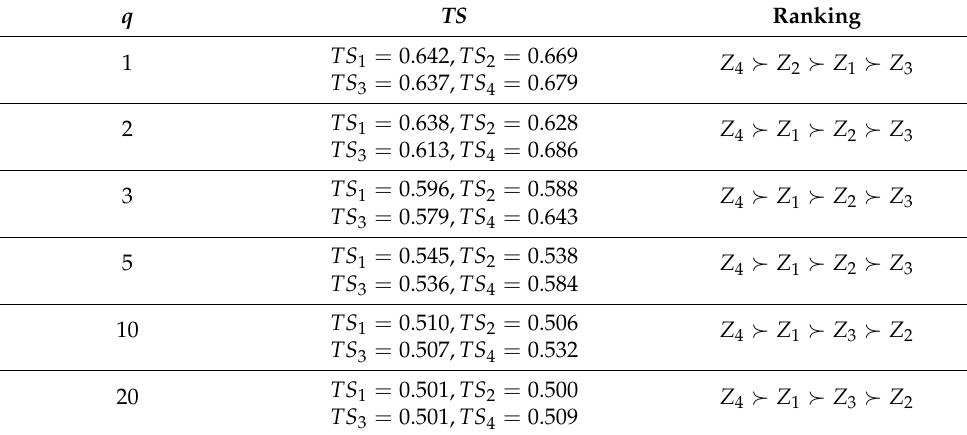
Table 1. Alternative ranking under parameter q .